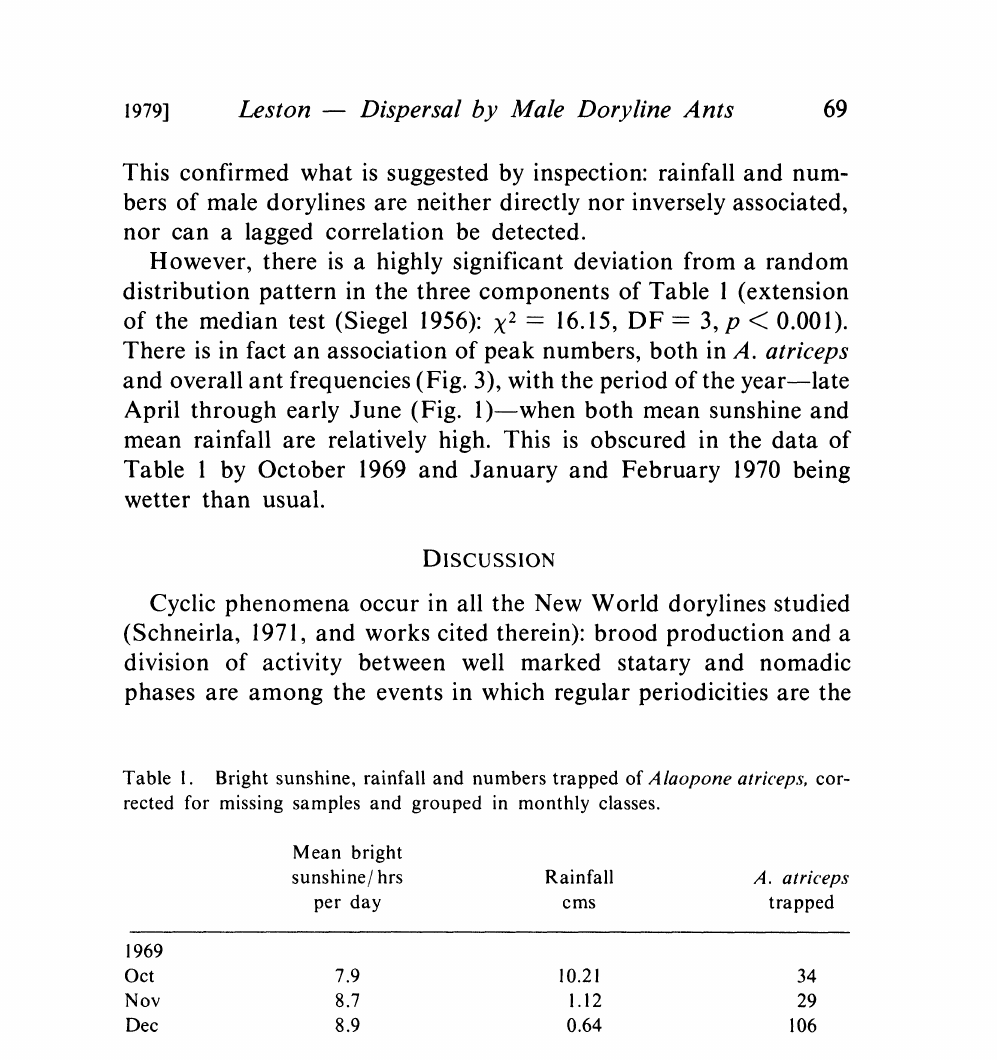
Table 1. Bright sunshine, rainfall and numbers trapped of A laopone atriceps, cor- rected for missing samples and grouped in monthly classes. Mean